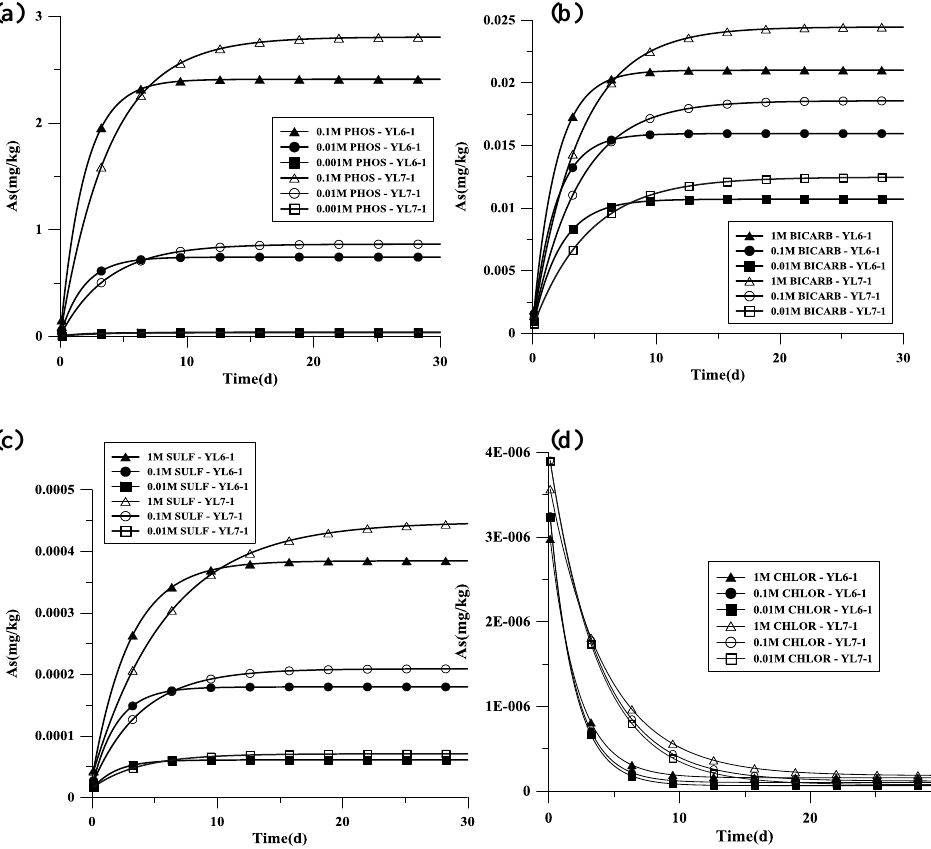
Fig. 9. Simulated time-dependent As desorption of YL6-1 and YL7-1 at various anionic concentrations (a) PO 3 − and (d) Cl −